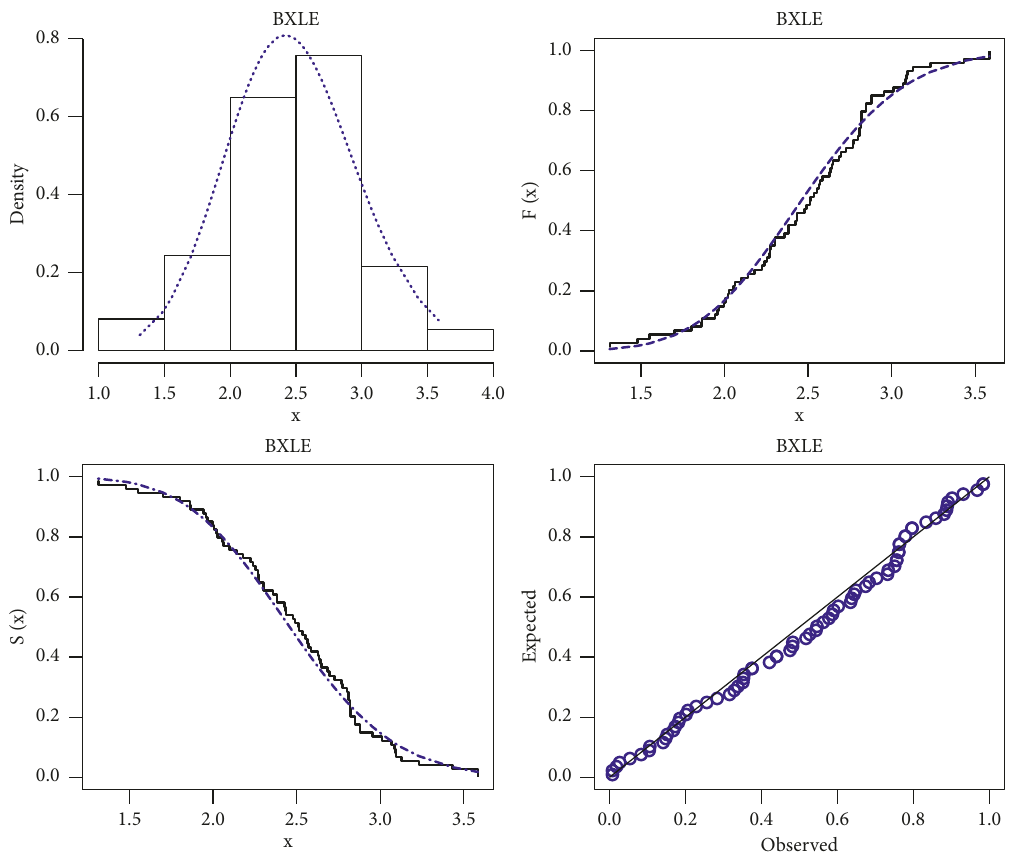
Figure 3: The fitted BXLE PDF, CDF, SF, and P-P plots for first